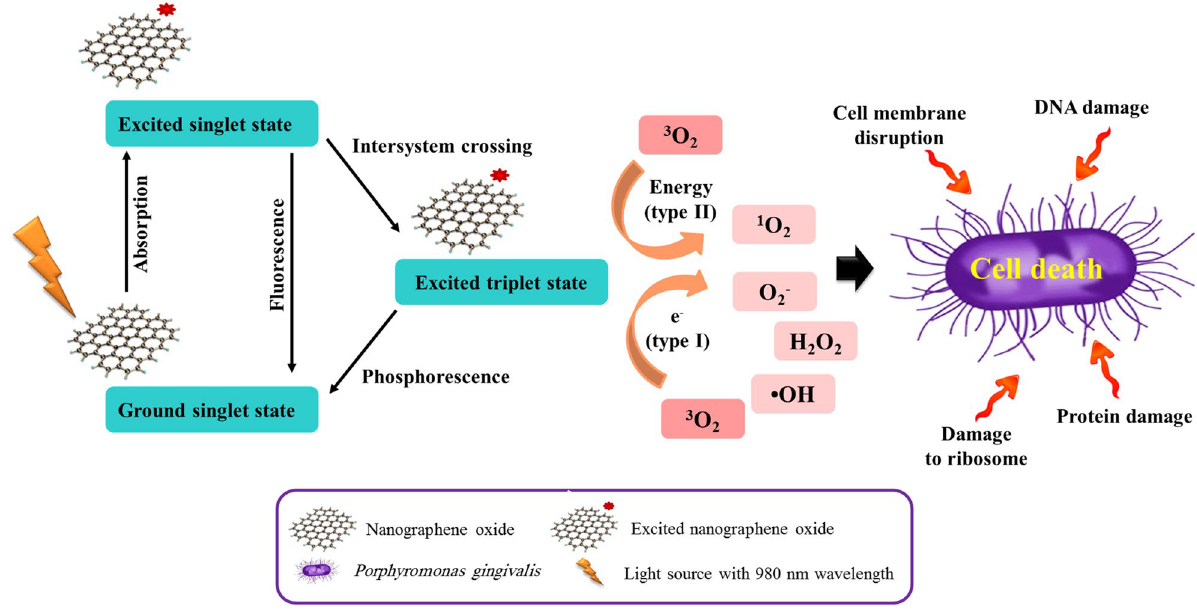
Figure 1. Schematic illustration of antimicrobial photodynamic therapy mechanism using nanographene oxide